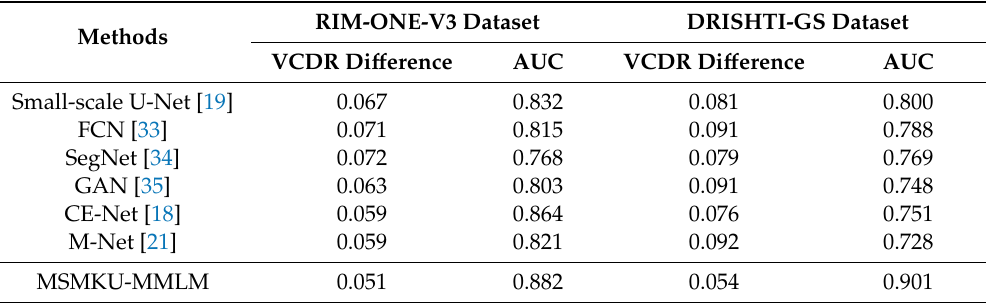
Table 5. Vertical cup-to-disc ratio (VCDR) and area under the curve (AUC) Comparisons of different methods.